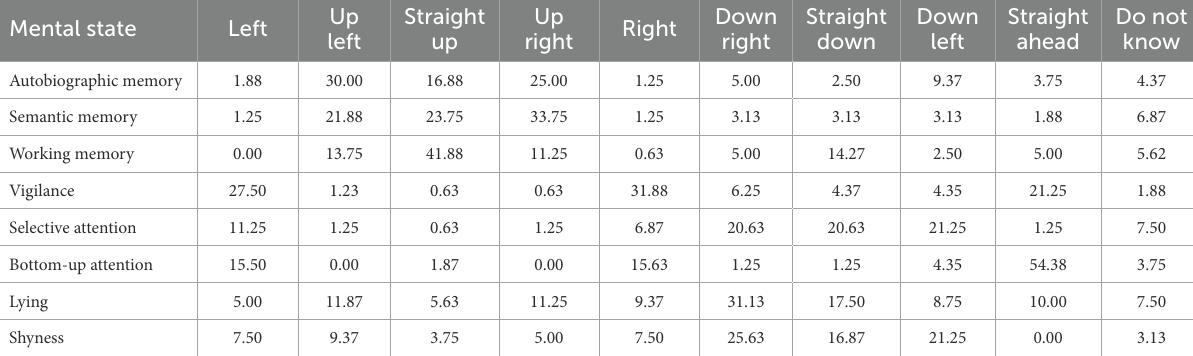
Up Straight Up Down Straight Down Straight Do not Right left up right right down left ahead know